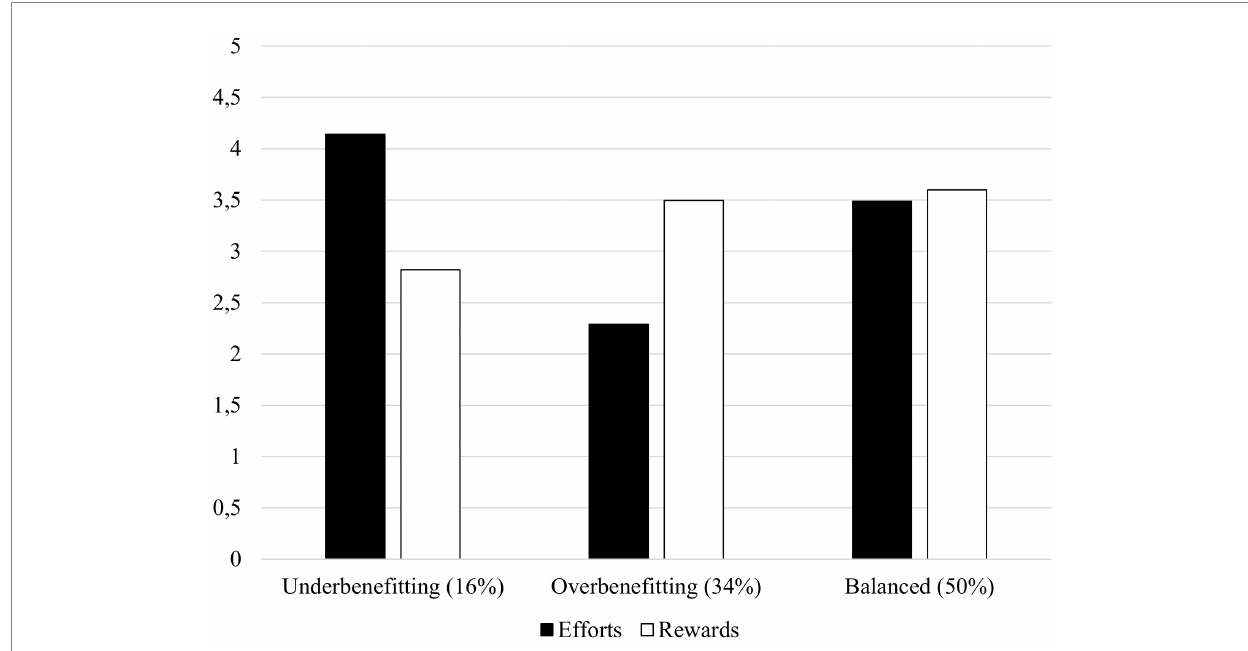
FIGURE 1 The three-profile solution for different combinations of efforts and rewards at work. Mean values are presented on the vertical axis. Percentages represent proportions from the